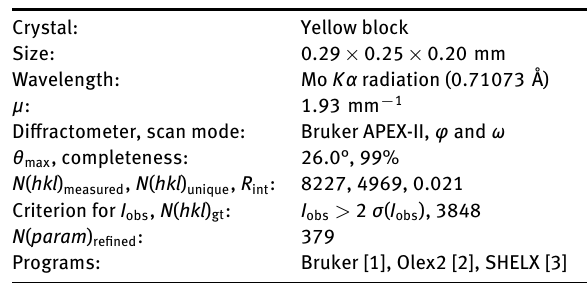
Table 1: Data collection and